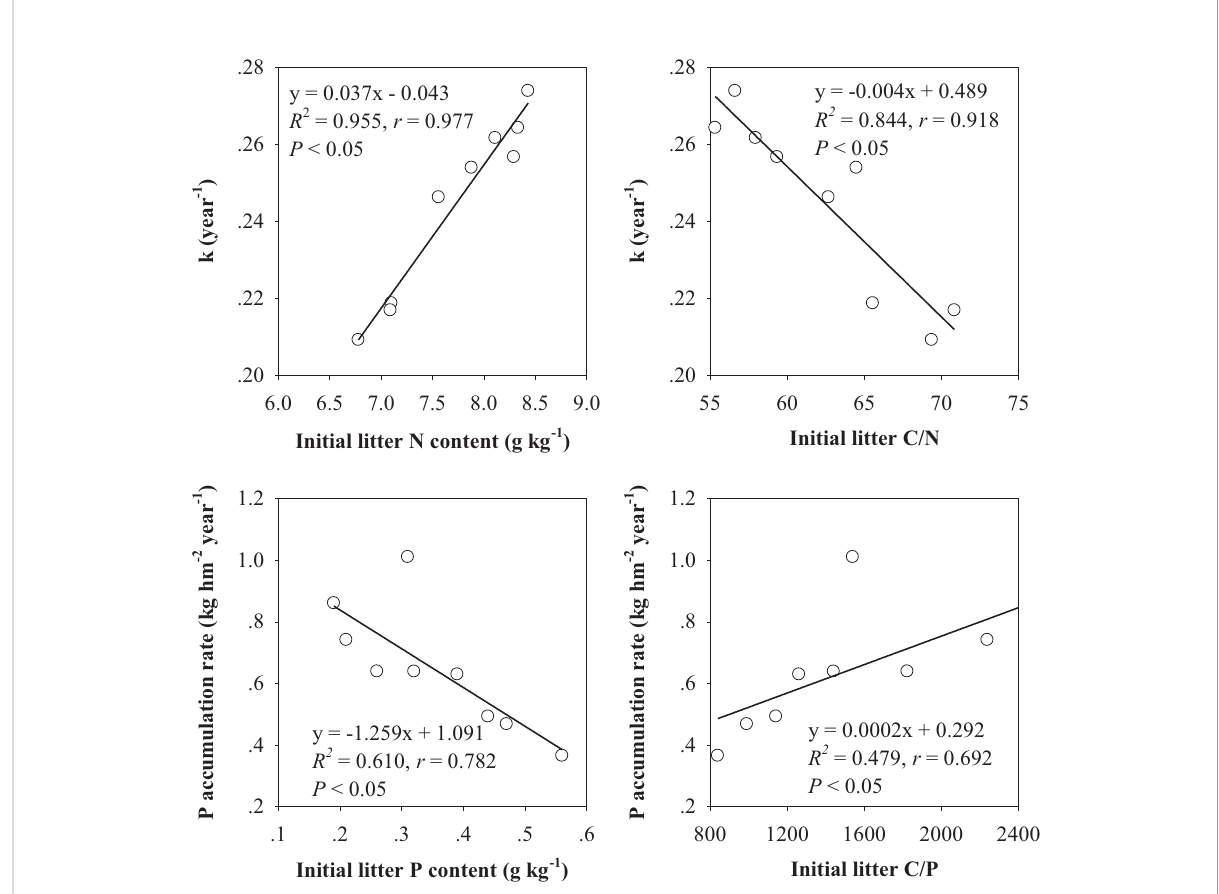
decomposition rate (Zhang et al., 2016). These results are consistent with those reported by prior studies (Gosz et al., 1973; Zheng et al., 2017b). Therefore, the N and C/N could be considered ideal susceptibility indicators of litter decomposition (Mafongoya et al., 2000; Go ́ mez-Muñoz et al., 2014).